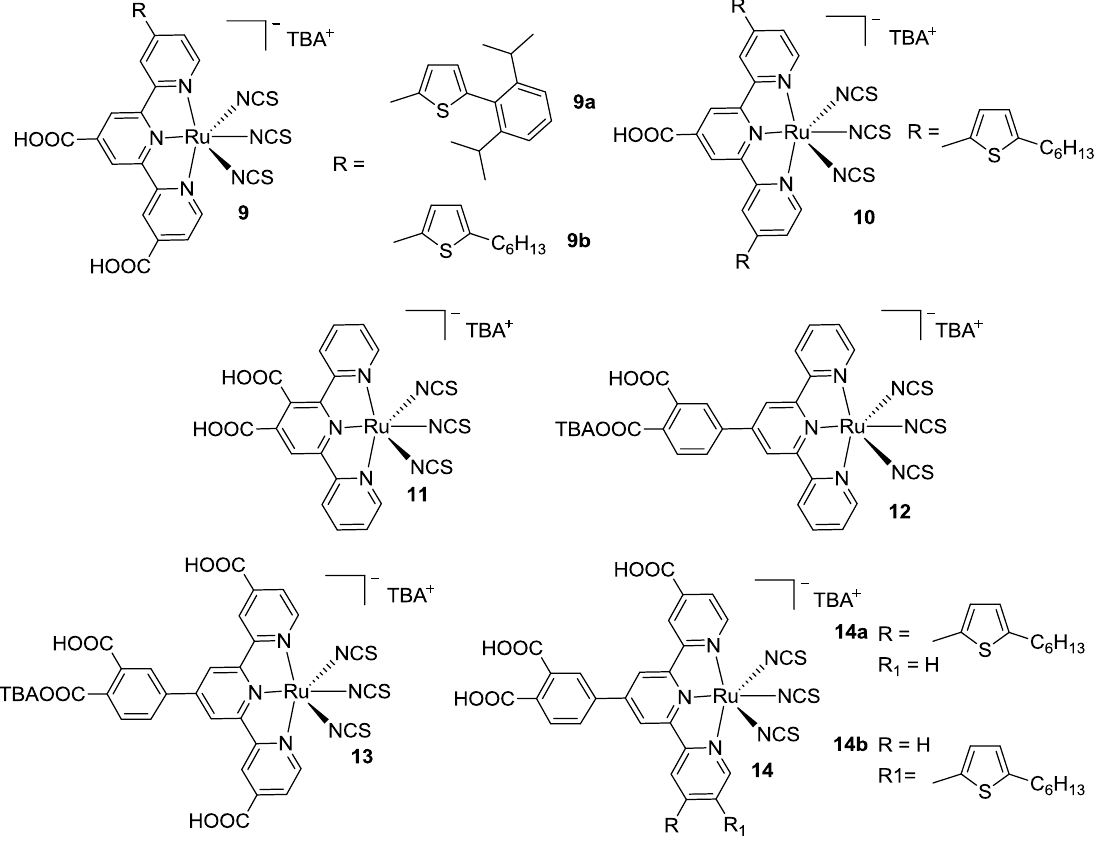
Figure 11. Structures proposed by Ozawa et al. [82–87].